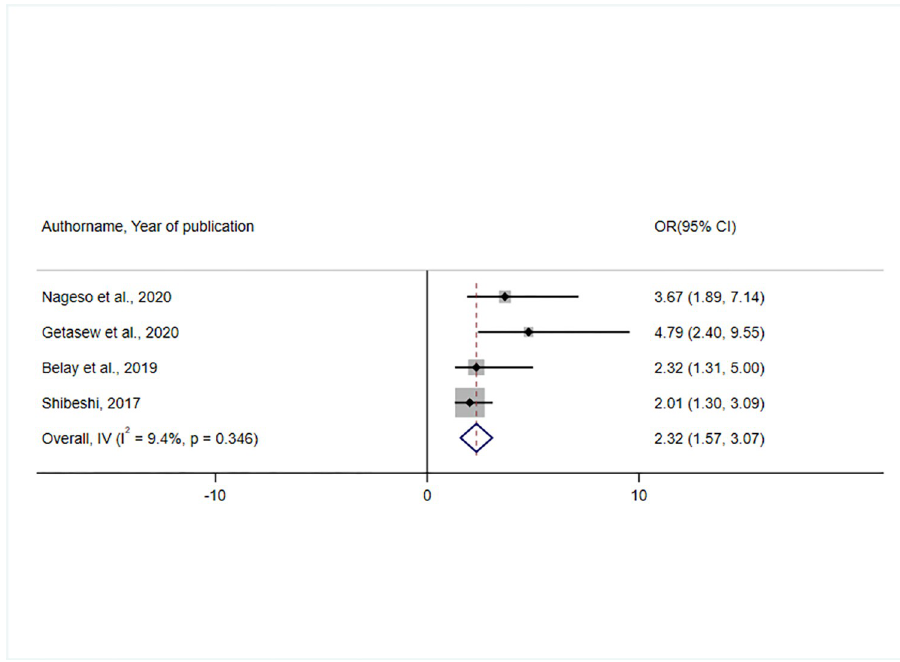
Fig 11. A forest plot showing the association between having trust in the scheme and CBHI enrolment in Ethiopia, 2017–2022.